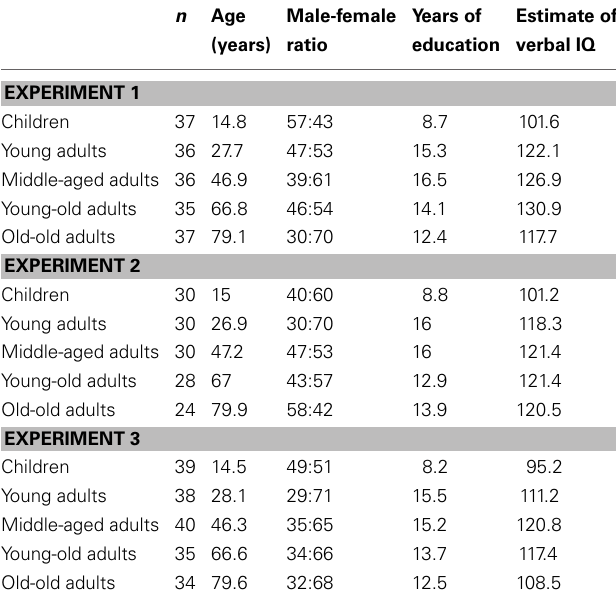
Table 1 | Descriptive characteristics of the samples for each